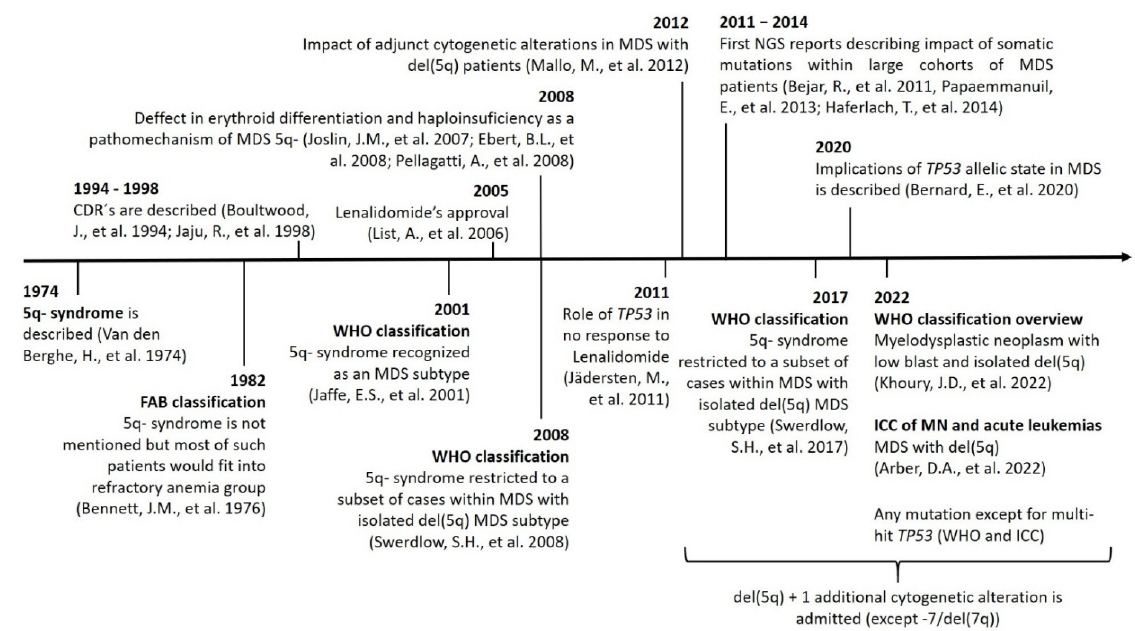
Figure 1. Timeline showing the main discoveries involving MDS-5q and the changes in nomenclature and inclusion criteria. Abbreviations: CDR, commonly deleted region; chr, chromosome; ICC: International Consensus Classification; MN, myeloid neoplasms; NGS, next ‐ generation sequencing.